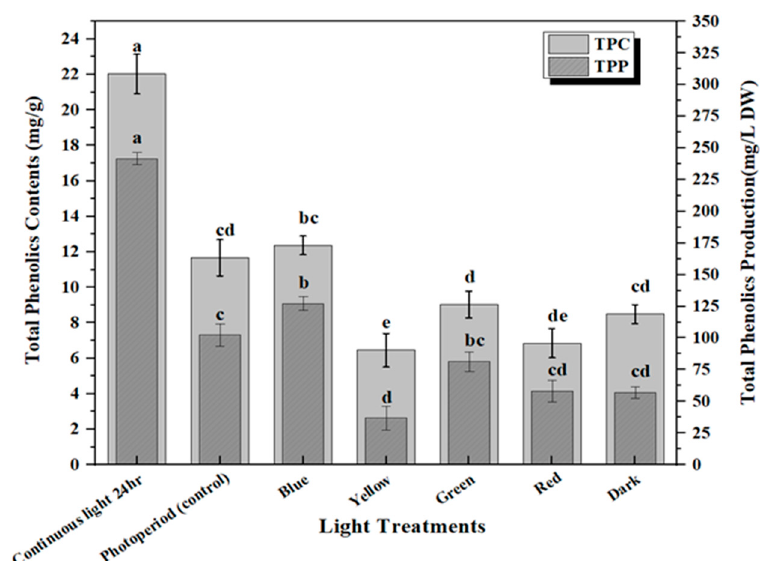
Figure 3. Differential effect of lights on TPC (mg/g DW) and TPP (mg/L) accumulation in in vitro callus cultures. The columns with similar letters are not statistically significant at p < 0.05.